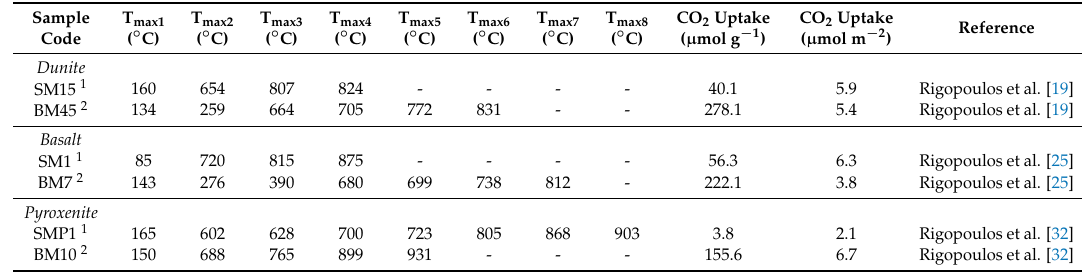
Table 3. Peak maximum desorption temperatures (T max ) and amounts of CO 2 uptake ( µ mol g − 1 ) (after chemisorption from a 5 vol% CO 2 /He gas mixture) estimated from CO 2 –TPD experiments for the starting dunite, basalt and pyroxenite, and the ball-milled samples with the highest CO 2 uptake. The CO 2 uptake per unit area of solid ( µ mol m − 2 ) was also calculated after dividing the amount of CO 2 uptake per gram basis ( µ mol g − 1 ) to the BET specific surface area (m 2 g − 1 ) of each solid (BET values are given in Tables 1 and 2).